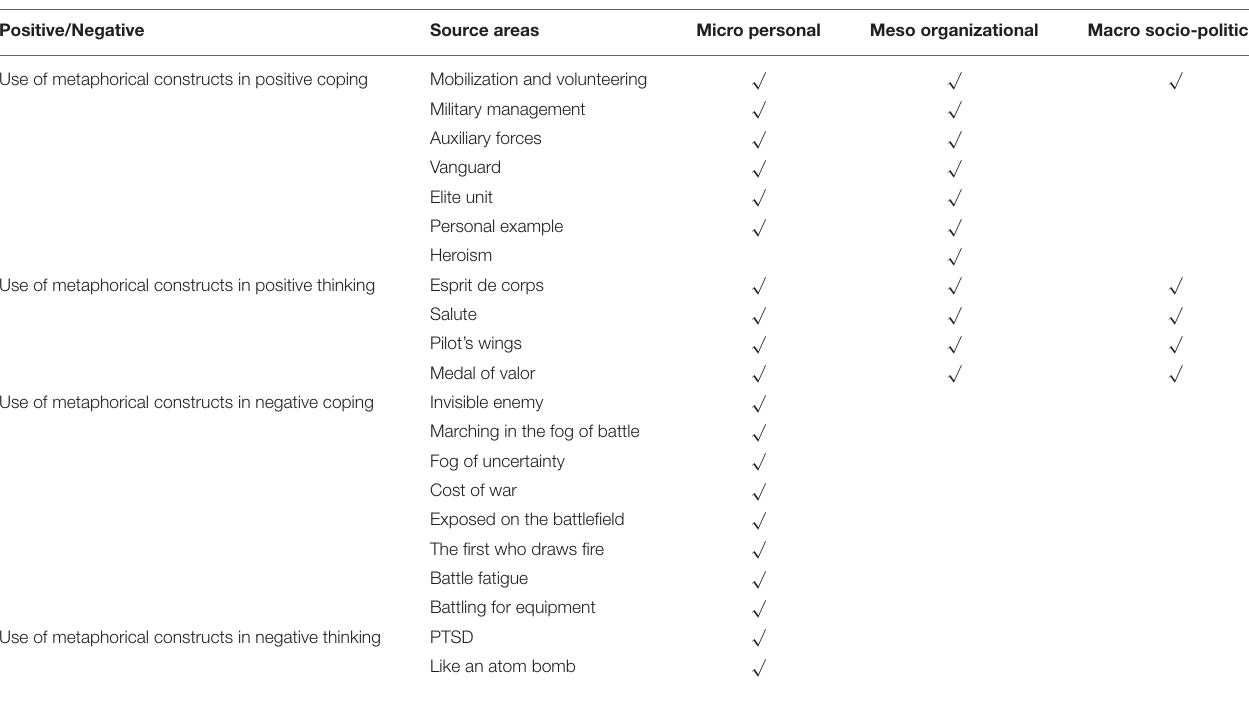
TABLE 2 | Source areas and modes of positive and negative coping.